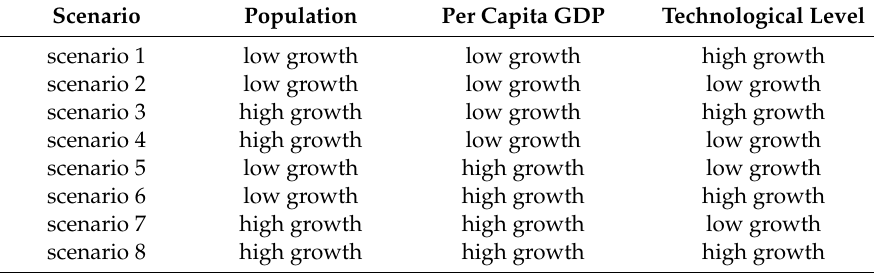
Table 10. Scenario Table 10. Scenario settings.